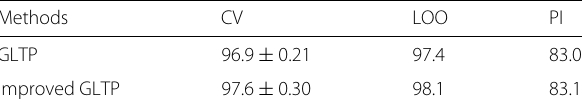
Table 2 Recognition rate (%) for 7-class emotion in CK+ dataset using GLTP and Improved